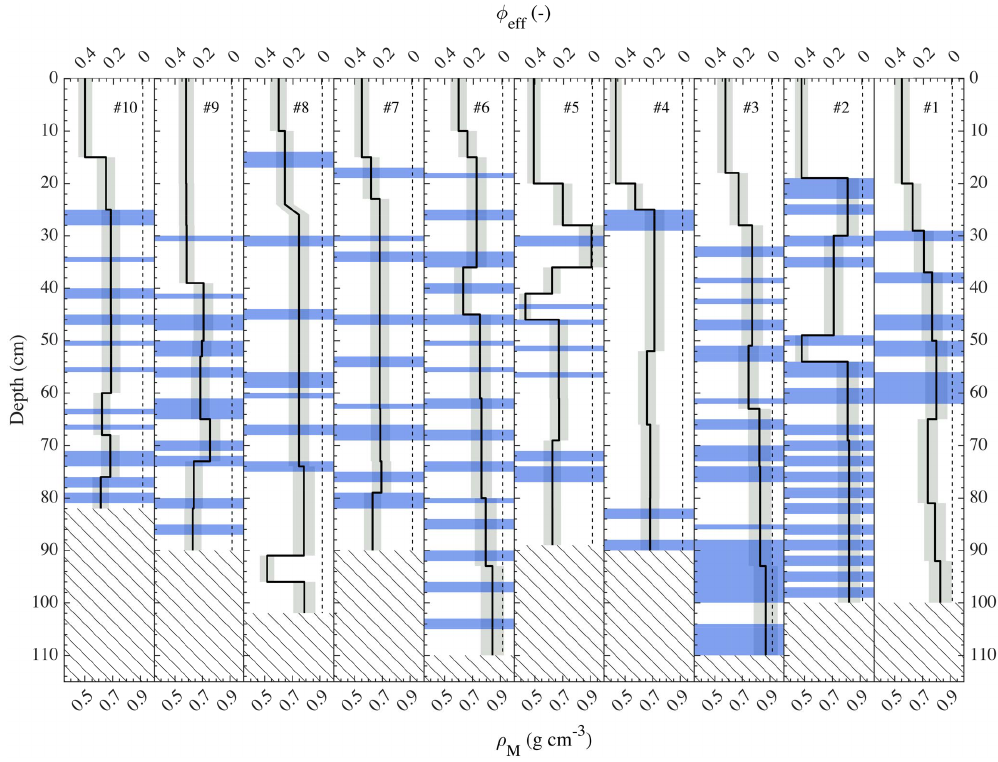
Figure 4. Subsurface measured ice density ( ρ M ) and corresponding calculated effective porosity ( φ eff ), and stratigraphy profiles from 10 shallow ice cores (#10–1, left to right) extracted at 80m intervals along the study transect (see Fig. 2 for ice core locations). Horizontal blue shading represents solid ice layers. Vertical dashed line at solid ice density 0.917gcm − 3 . Assumed ± 10% measurement uncertainty represented by shaded grey bars. Hatched areas are no data.